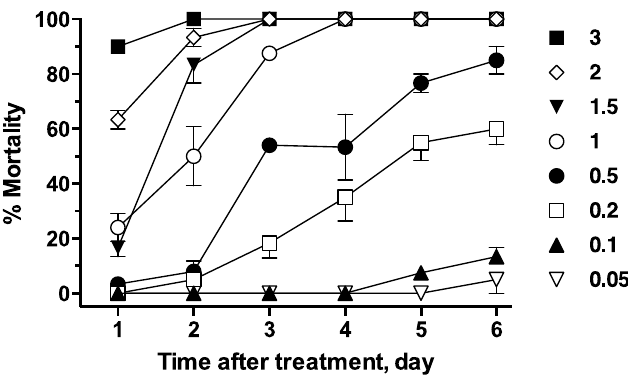
Figure 3. Mortality data for adult topical assay showing the increase of toxicity over time at a range of doses labeled to the right of the symbols and expressed as ng/mosquito. No mortality was observed in controls over six days when treated with solvent vehicle.